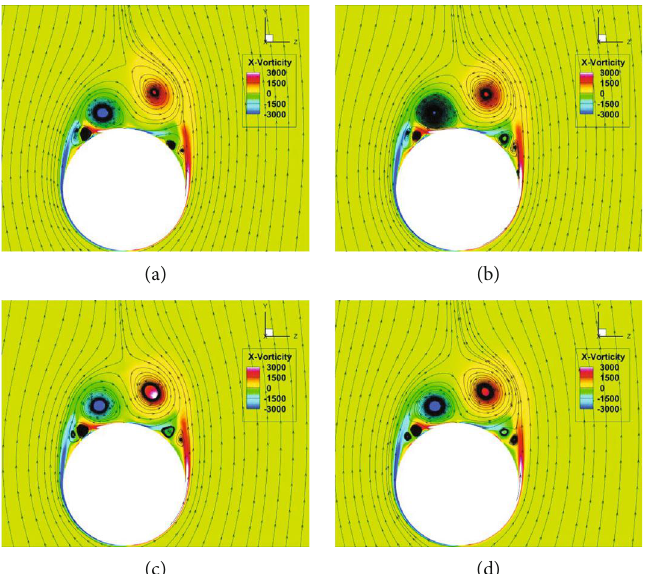
Figure 19: Contrast contour of X -vorticity with di ff erent roughness values at section 2: (a) Model 1, (b) Model 2, (c) Model 3, and (d) Model 4.